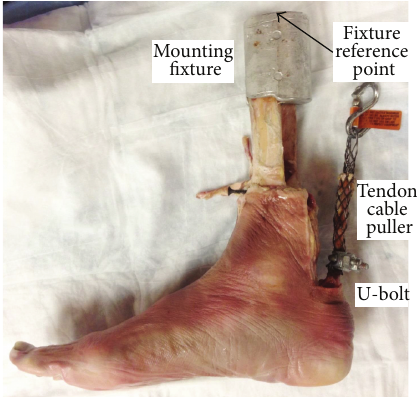
Figure 1: A prepared below the knee lower extremity